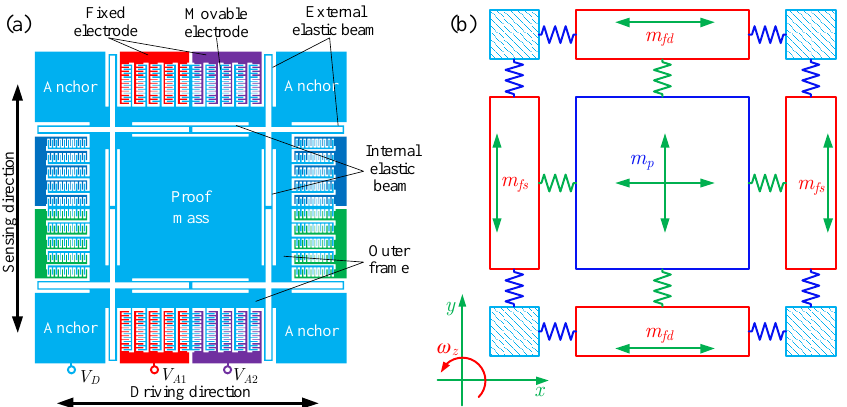
Figure 1. The schematic diagram of the symmetrical MEMS gyroscope and the corresponding spring- mass model, ( a ) schematic diagram of the symmetrical MEMS gyroscope [16], and ( b ) corresponding spring-mass